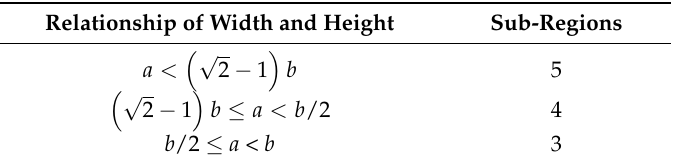
Table 1. Relationship between the rectangular geometry and the possibility of discontinuities. Relationship of Width and Height